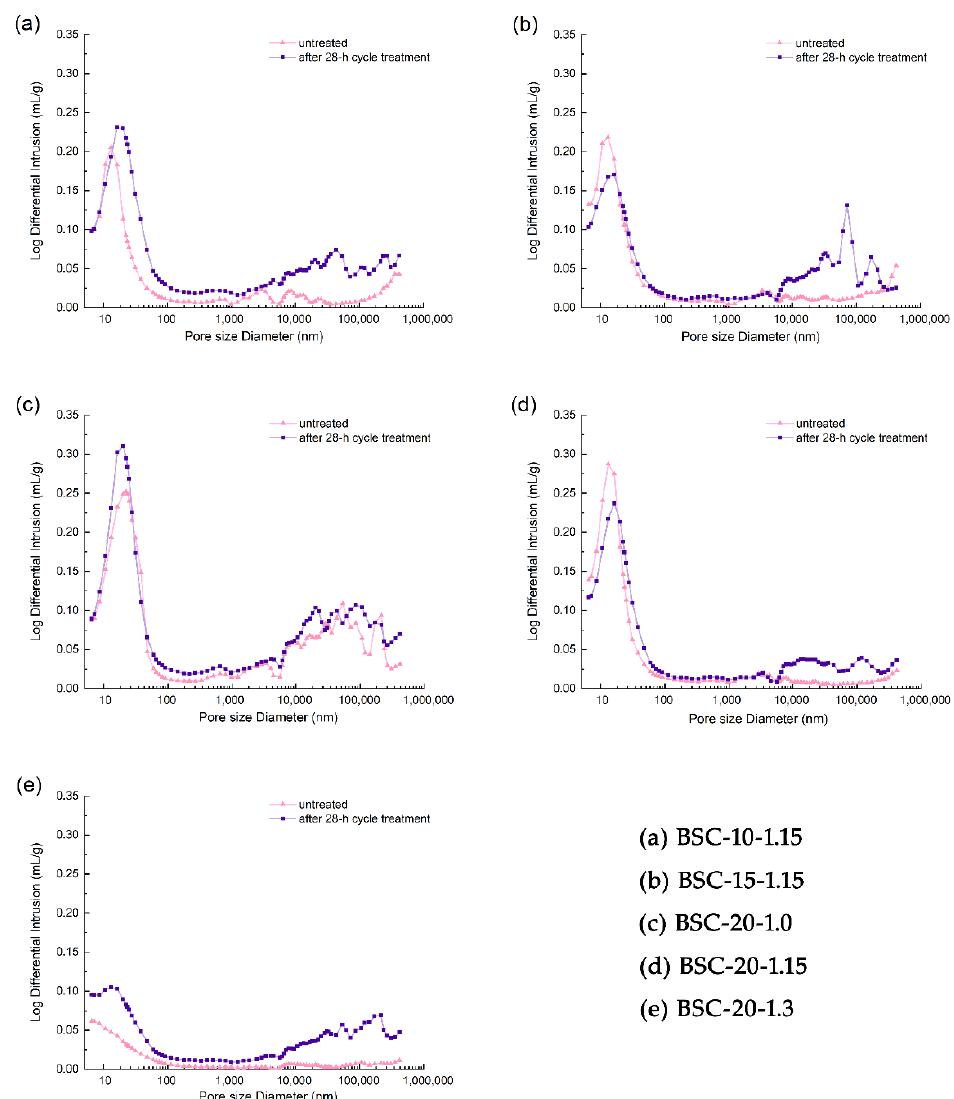
Figure 10. Pore size distribution of the BSC samples before and after 28-h cycle treatment. Note: ( a ) BSC-10-1.15; ( b ) BSC-15-1.15; ( c ) BSC-20-1.0; ( d ) BSC-20-1.15; ( e ) BSC-20-1.3.